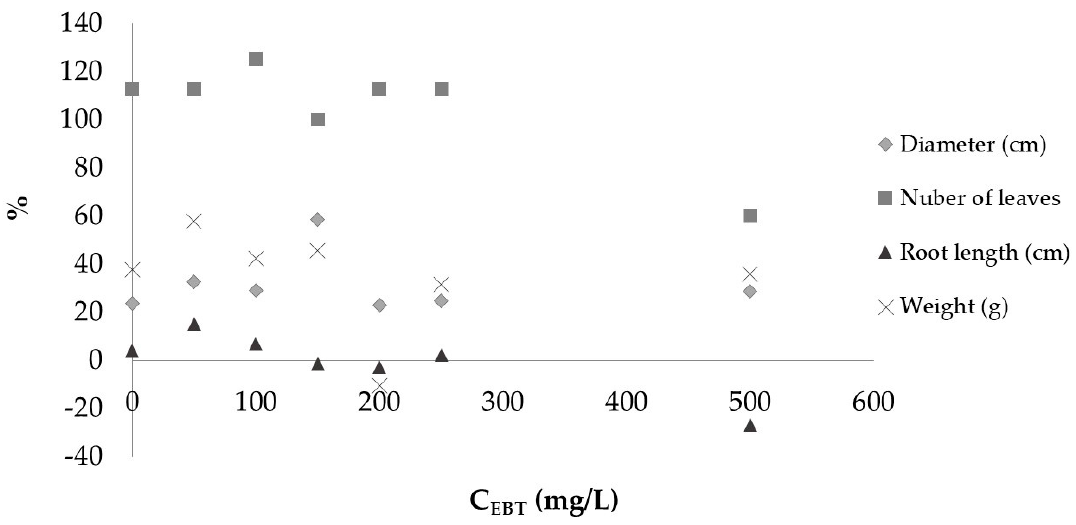
Figure 5. Percentage of morphological changes of E. crassipes.